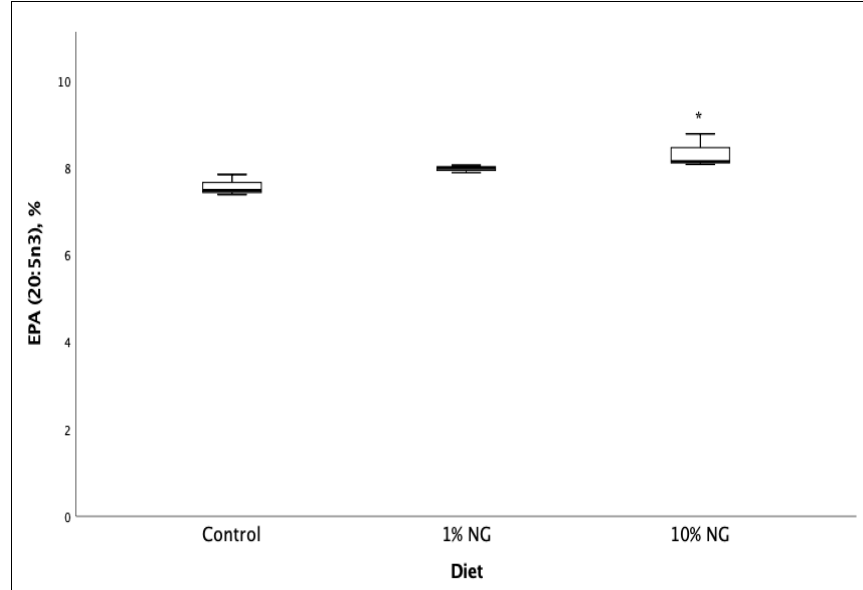
Figure 1. Salmon meat vitamin D 3 composition after 49 days of feeding the experimental diets. NG = Nannochloropsis gaditana , *Significantly different from control ( p < 0.05) Values are based on the mean ± S.D. n = 5.